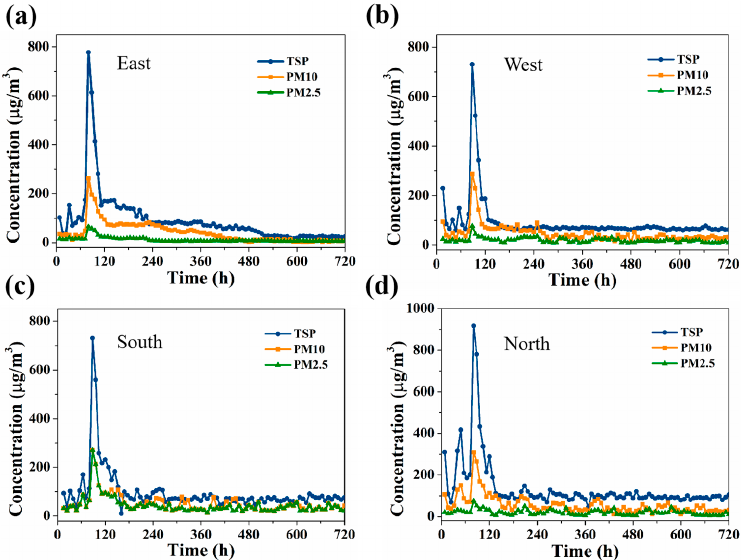
Figure 6. Real-time monitoring the concentrations of TSP, PM 10 , and PM 2.5 from the direction of ( a ) East, ( b ) West, ( c ) South, and ( d )